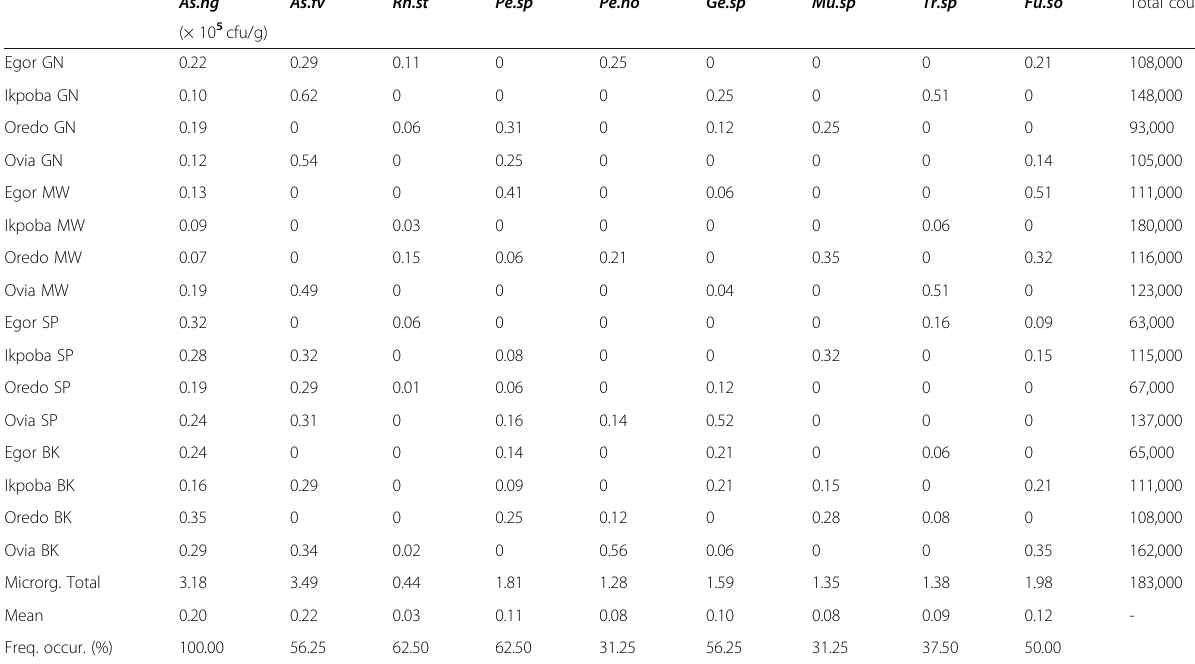
Table 3 Fungal counts in the spent crude oil-polluted soil within Benin metropolis As.ng As.fv